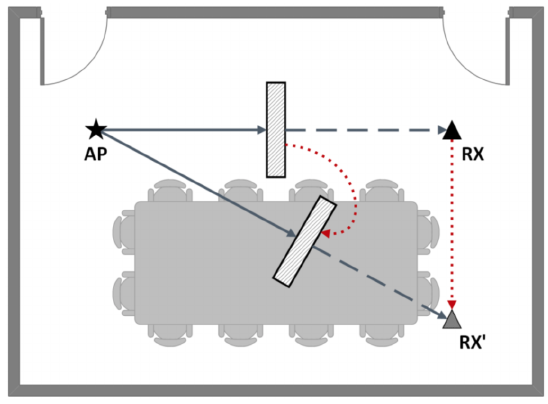
Figure 11. The scenario of LOS/NLOS identification.